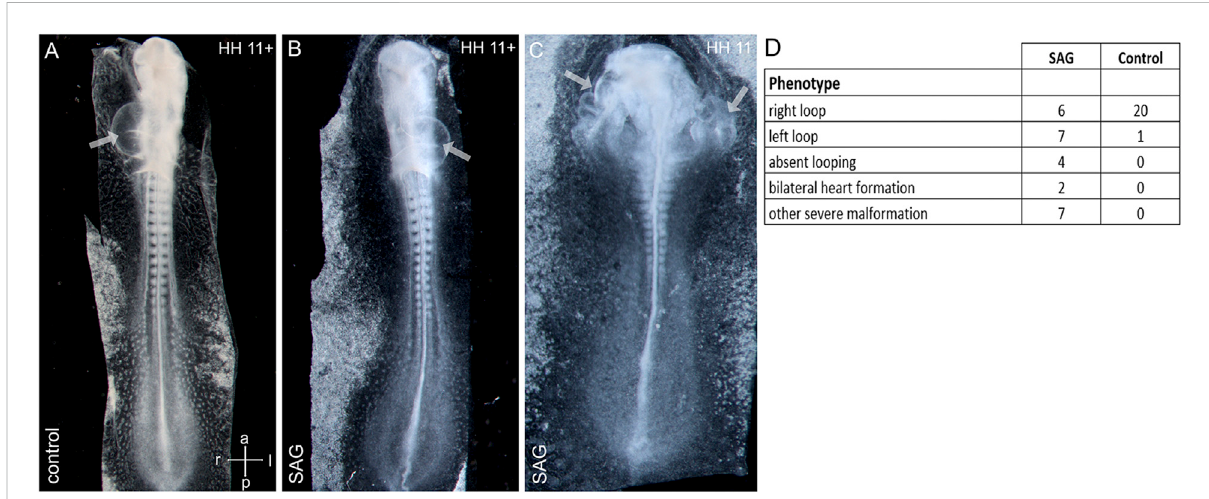
FIGURE 4 Abnormal cardiac development after treatment with an activator of hedgehog signaling SAG. (A – C) : examples of right-sided (A) , left-sided looping (B), and bilateral heart development (C) after SAG treatment. (D) Distribution of cardiac phenotypes in control and treated embryos. Arrows indicate heart tubes. Intersecting arrows indicate anatomical